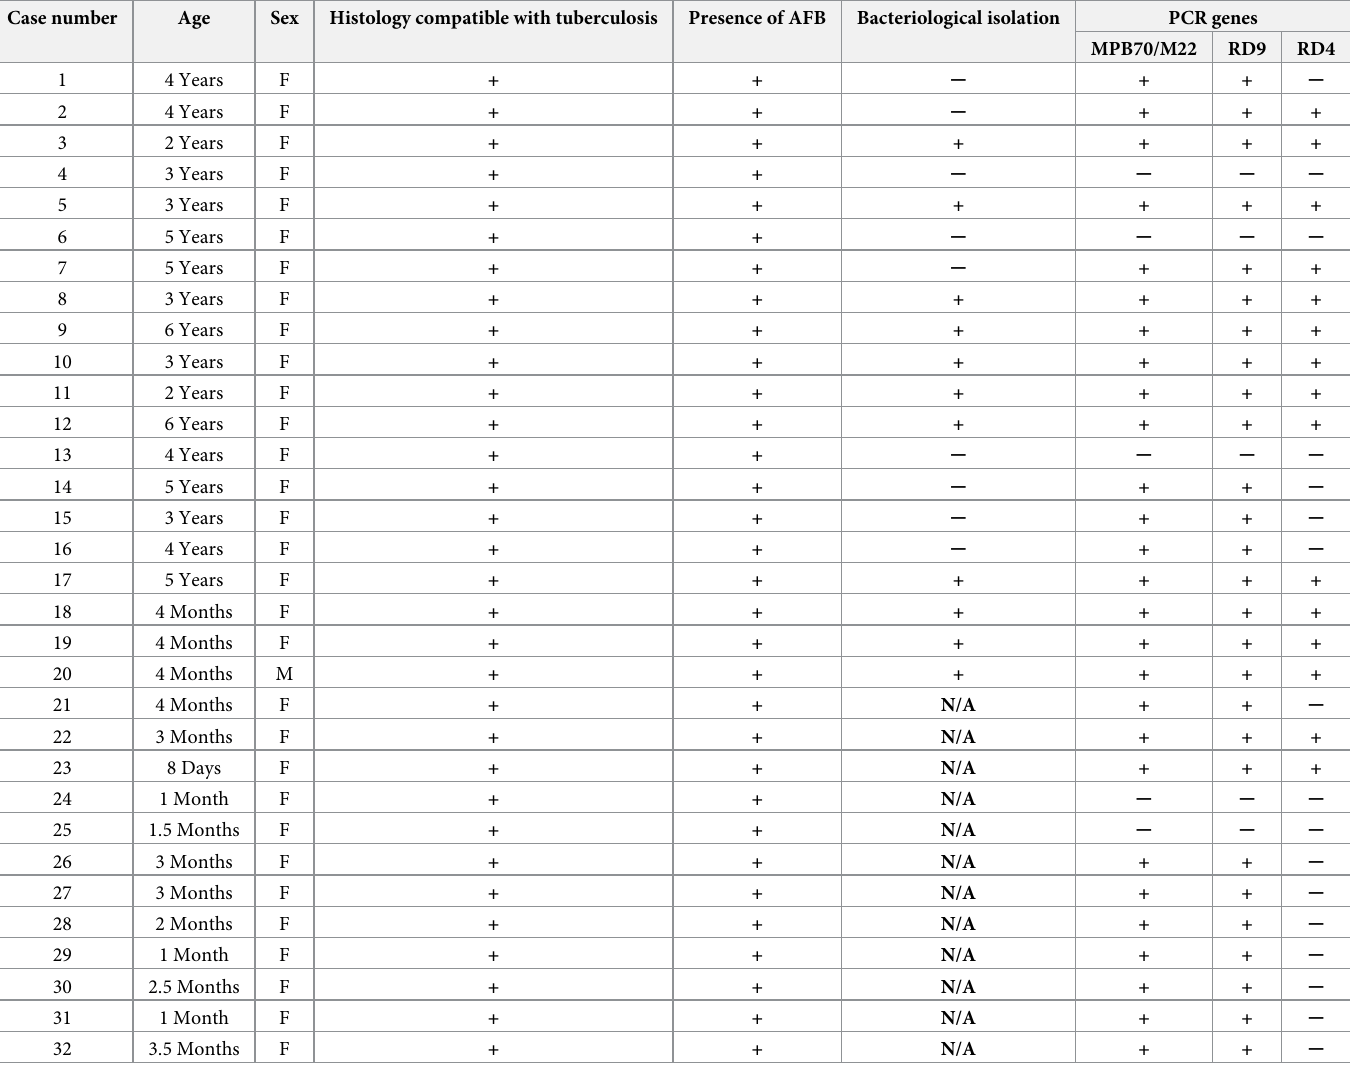
Table 2. Bacteriological isolation and molecular genotyping of M . bovis . Case